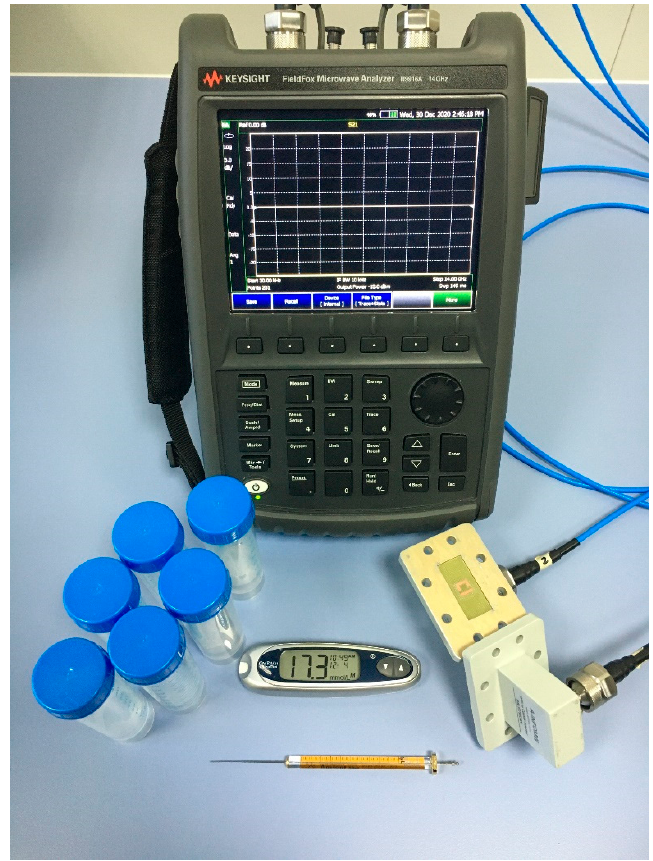
Figure 2. The measurement setup including the 137WCAN right-angled rectangular waveguides, the SASR structure, the samples, the syringe from Agilent model 5181-1267, the glucometer model OneTouch UltraMini and the vector network analyzer model N9916A.